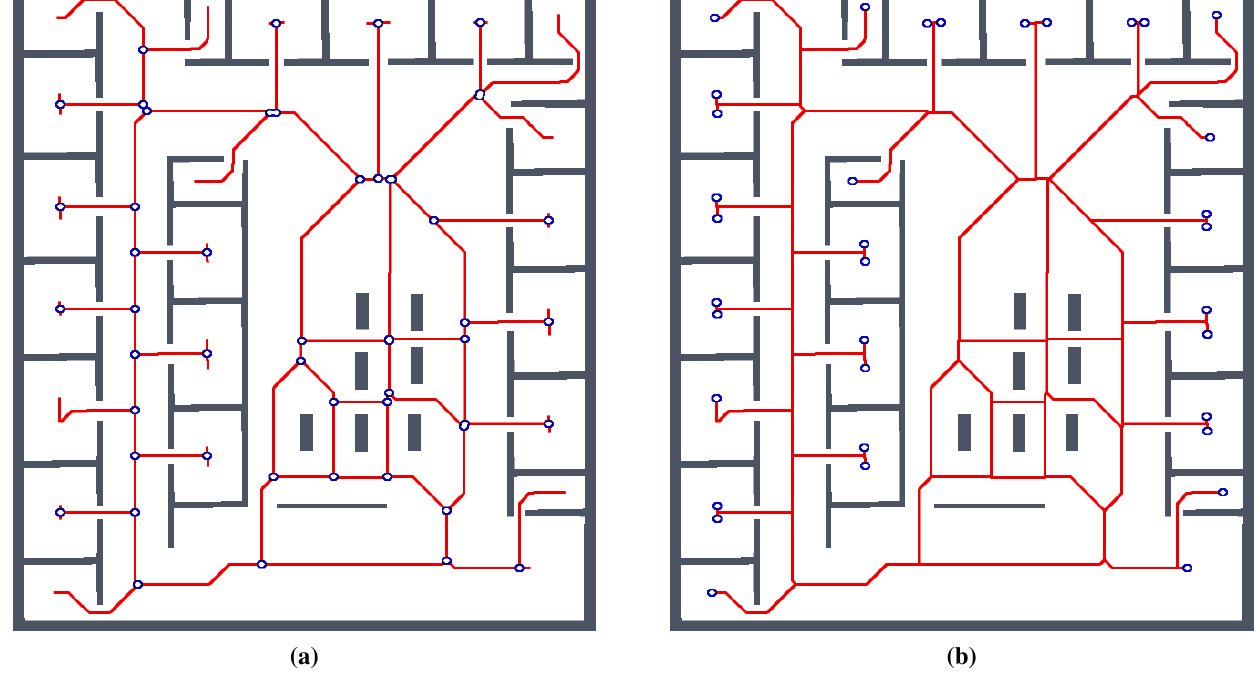
Figure 6. Example of the topology representation of the walled environment jh computed as the GVG of the grid map. The computed Voronoi diagram is transformed into a graph, where nodes with the degree (number of incident edges) higher than 2 represent junction places and nodes with the degree 1 are the leaves representing particular rooms. ( a ) junction places; ( b ) leaves.